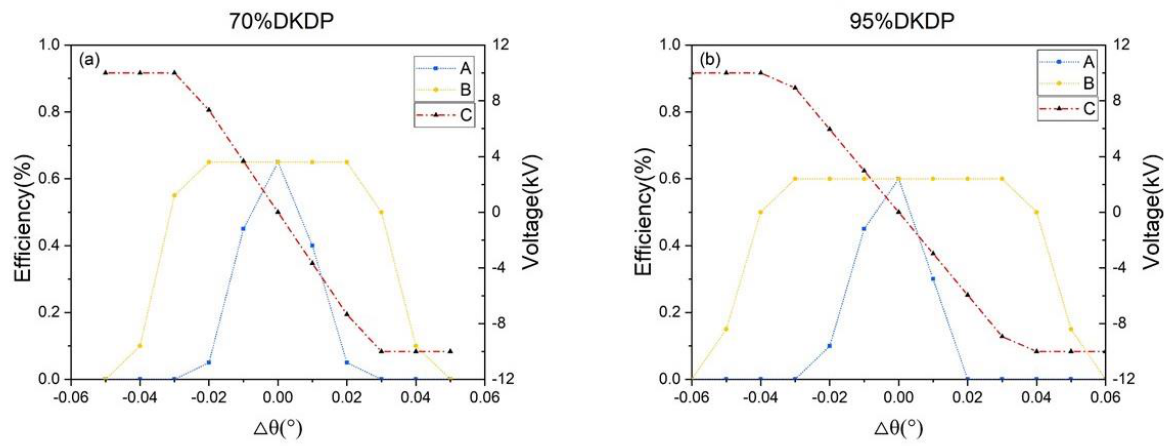
Figure 2. Calculated OPA efficiencies obtained via ( a ) 70%- and ( b ) 95%-deuterated DKDP versus angle and compensation voltage. Line A represents the OPA efficiency without compensation, Line B indicates OPA efficiency where the phase mismatch is compensated, and Line C represents the compensation voltage.